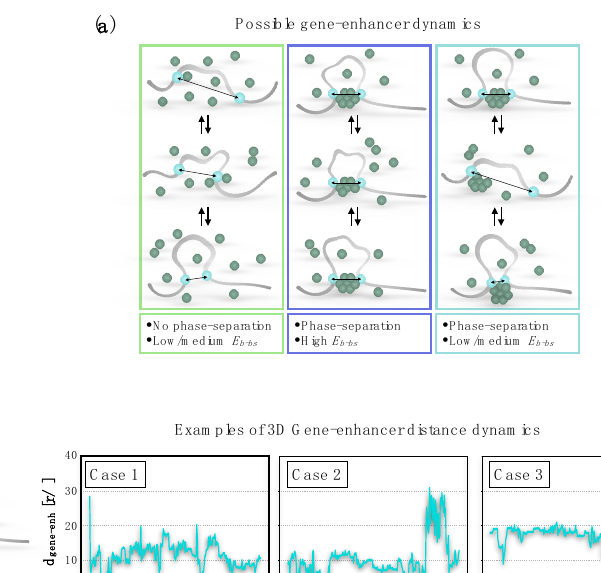
Figure 1. Polymer models and phase-separation in cell nucleus. ( a ) In the SBS model, the polymer chain has binding sites that can interact with diffusing molecules (binders) with affinity E b-bs . Binders can also self-interact, with affinity E b-b , so to drive the formation of phase-separated clusters. ( b ) Phase-diagram of the system as a function of binder concentration and binder–binder interaction affinity E b-b . Red indicates the formation of the phase-separated cluster; and blue indicates that the cluster is not formed. ( c ) Three-dimensional snapshot of the system without (blue) and with (red) phase-separated cluster. If formed, the phase-separated cluster mediates the contact between binding sites. Panels adapted from [35].